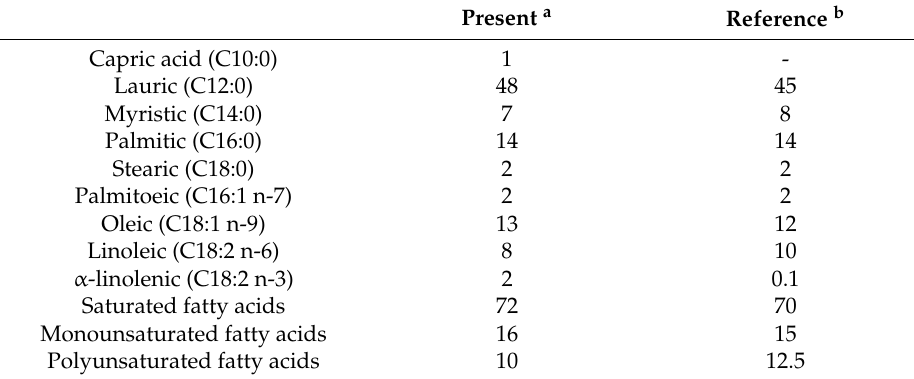
Figure 2. Lipid extracted with n-hexane. Table 2. Fatty acid composition (wt.% of total fatty acid